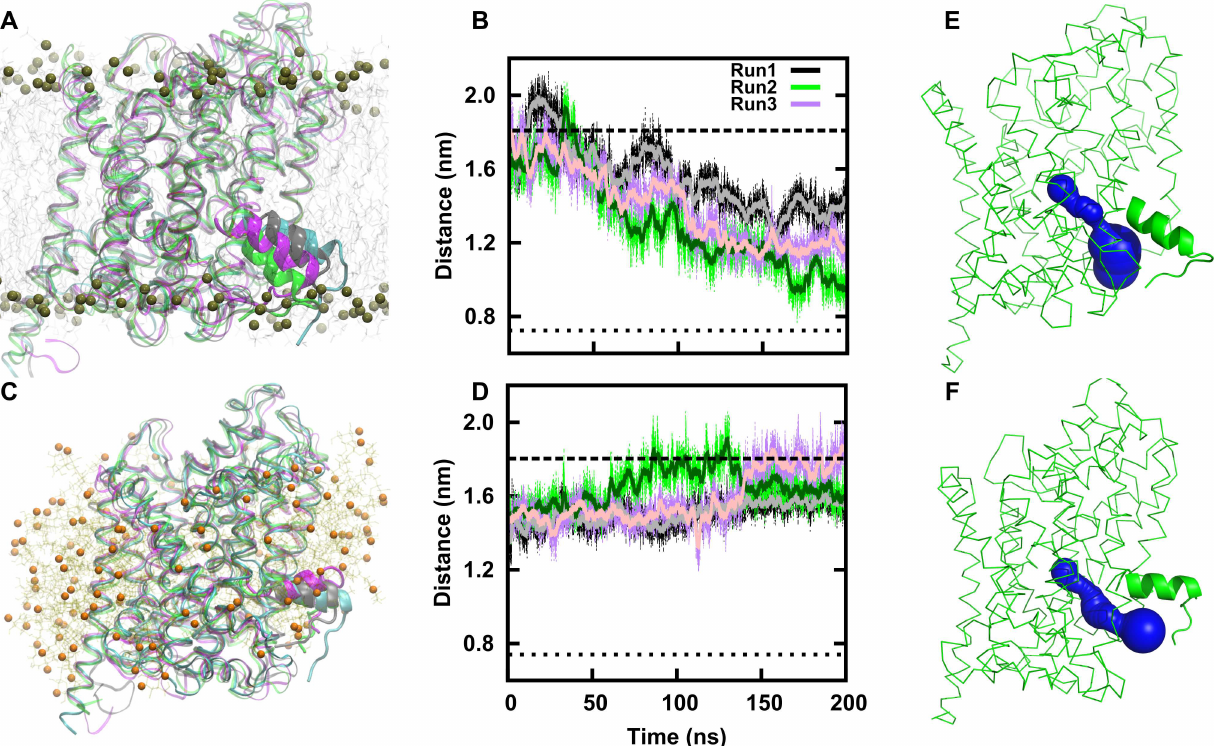
Fig 2. Dynamics of helix TM1A. (A) Comparison of the final structures of three independent simulations (grey, green, purple) of membrane- inserted LeuT with the inward-open crystal structure (PDB ID: 3TT3) shown in cyan. Lipid molecules are shown in grey, the dark spheres represent the phosphate atoms of the membrane lipids. (B) Change in vestibulesize of membrane inserted LeuT over time is quantifiedby measuringthe distance between the C α of residue M18 (TM1A) and Y265 (TM6). The values of each time frame (thin line) are shown together with a runningaverage over 100 frames (thick line). The distances as observed in the crystal structure of LeuT (dashedline for the inward-open structure with the PDB ID: 3TT3; a dotted line for the outward-occluded structure with the PDB ID: 2A65) are also shown. (C) Comparison of the final structures of three independent simulations (grey, green, purple) of micelle-inserted LeuT with the crystal structure (PDB ID: 3TT3) shown in cyan. Detergent BOG moleculesare shown in yellow, atom O1 as orange spheres. (D) Change in vestibule size as describedin B for detergent solubilized LeuT. (E, F) The size of the vestibuleis shown for the final conformation of run 2 of membrane- inserted LeuT (E) and of run 2 of micelle-inserted LeuT (F) . The protein is shown in green, the pore surface in blue, as calculated by the program caver